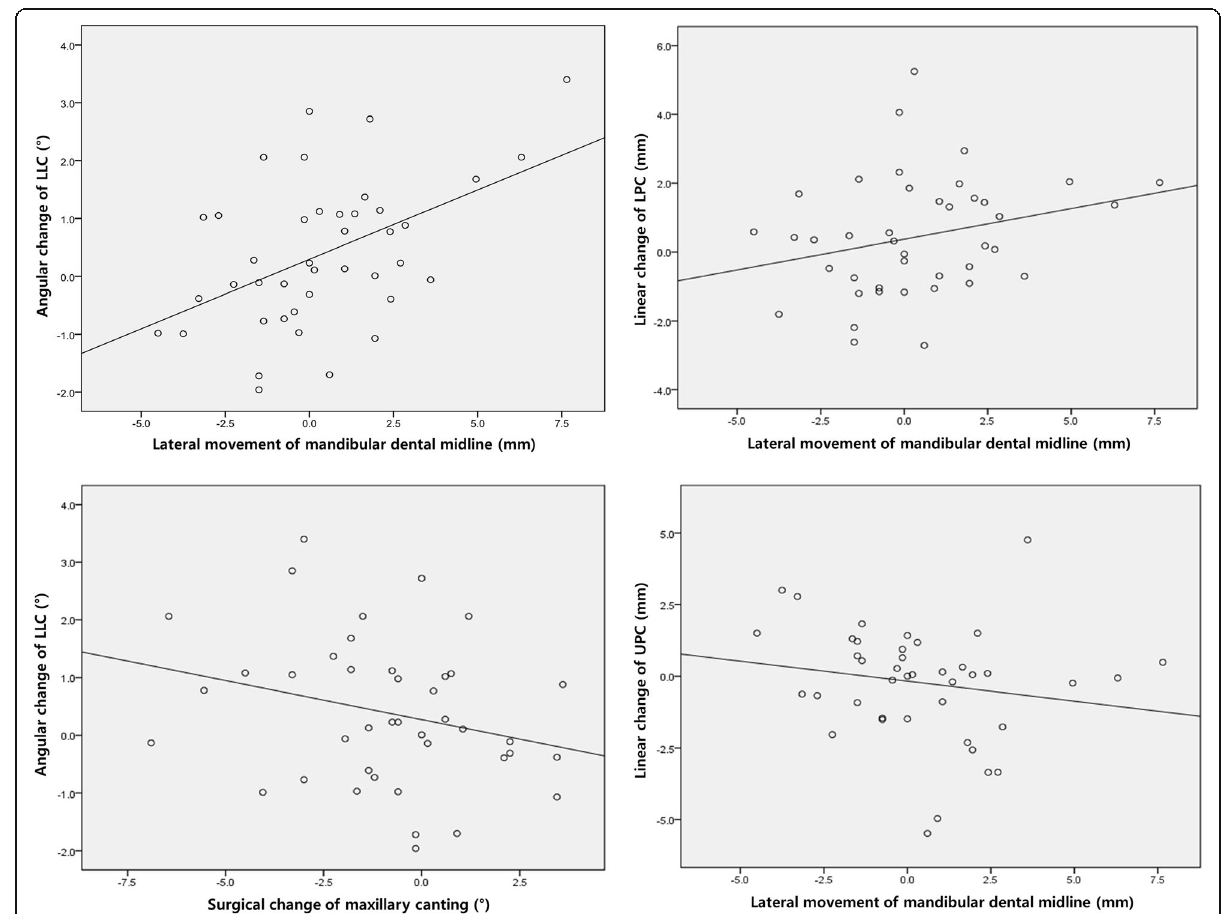
Fig. 3 Scatter plot that represents Spearman ’ s correlation between changes in the lip position and surgical